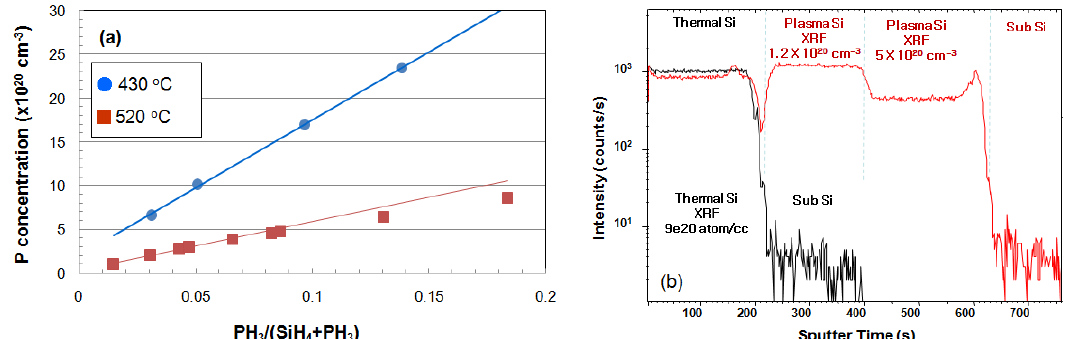
Figure 3. ( a ) Phosphorus (P)-concentration with the PH 3 flow rate; the blue circles represent the X-ray fluorescence (XRF) results of the Si grown at 430 ◦ C, and the red rectangles represent the XRF results of the Si grown at 520 ◦ C. ( b ) The secondary ion mass spectrometry (SIMS) profile of the Si layer grown by thermal CVD (black) and MW-CVD (520 ◦ C, red).